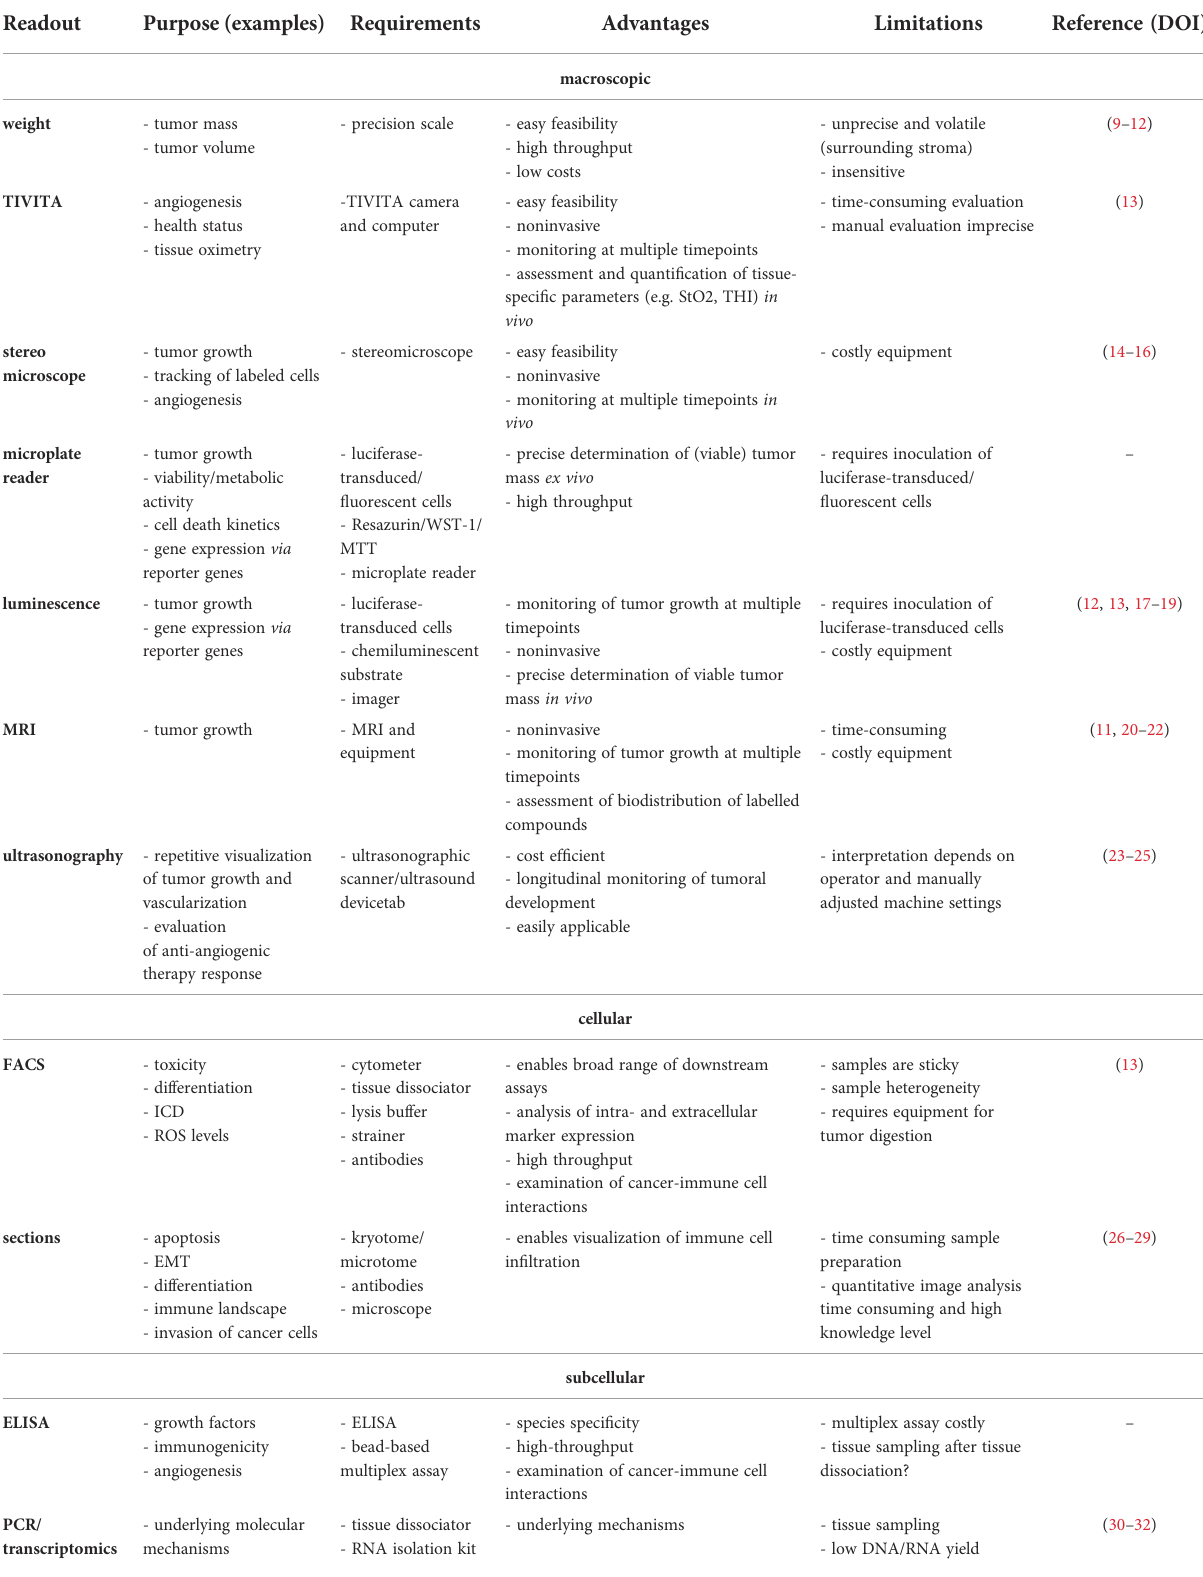
TABLE 1 Advantages and limitations of methods that have been established in ovo